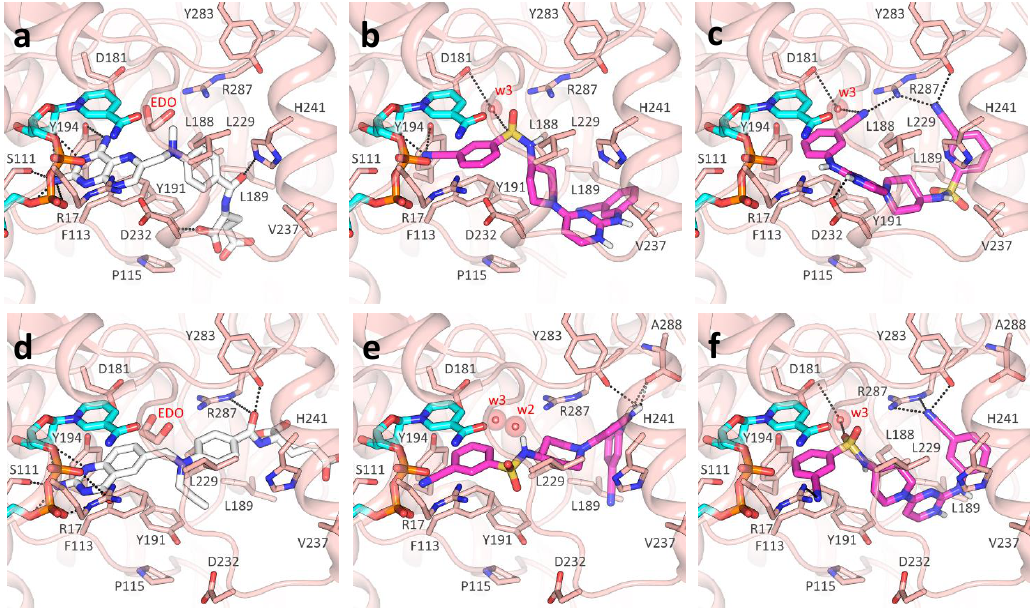
Figure 6. TCMDC-143249 docking poses in LmPTR1. ( a ) MTX (white) main polar contacts in PDB ID 1E7W. ( b , c ) Two orientations of TCMDC-143249 (magenta) docked in PDB ID 1E7W. ( d ) Co-crystallized dideazafolate ligand (white) main polar contacts in PDB ID 2BFA. ( e , f ) Two orientations of TCMDC-143249 (magenta) docked in PDB ID 2BFA. Protein is represented as pink cartoon, with relevant binding site residues depicted as sticks and labelled. NADPH cofactor (cyan) and ligands are shown as capped sticks, polar interactions between ligands and protein are shown as black dashed lines. Water molecules, indicated when not displaced by the docking, are reported as red spheres with their Van der Waals radius visible in transparency. For clarity, polar hydrogens are shown for ligands only. 1,2-Ethanediol (EDO), a cryopro- tectant mimicking ordered water molecules in PDB IDs 1E7W and 2BFA, is reported as sticks in a and d, and was substi- tuted by water molecules w2 and w3 in docking studies ( b , c and e , f ).